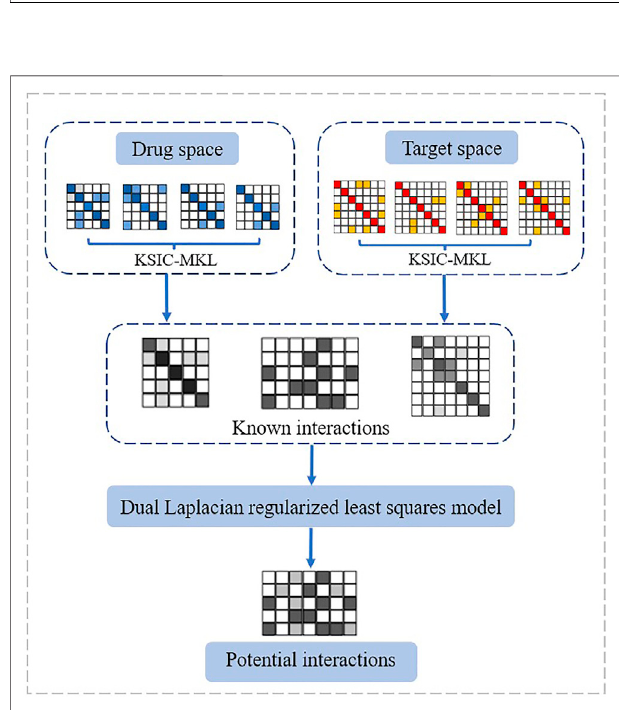
FIGURE 5 | Flowchart of